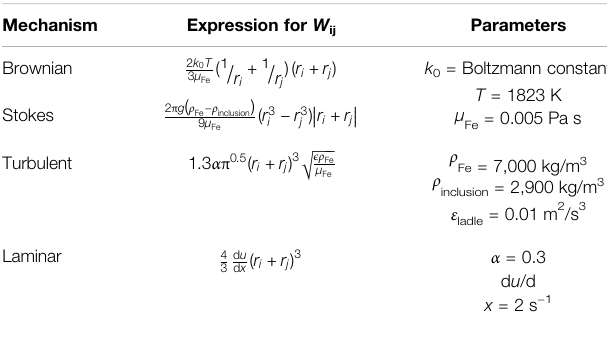
TABLE 3 | Expressions for collision volumes (Söder et al. (2004). The sources of speci fi c parameters are as follows: ε ladle and α (Taniguchi and Kikuchi (1992); d u /dx (Piva,